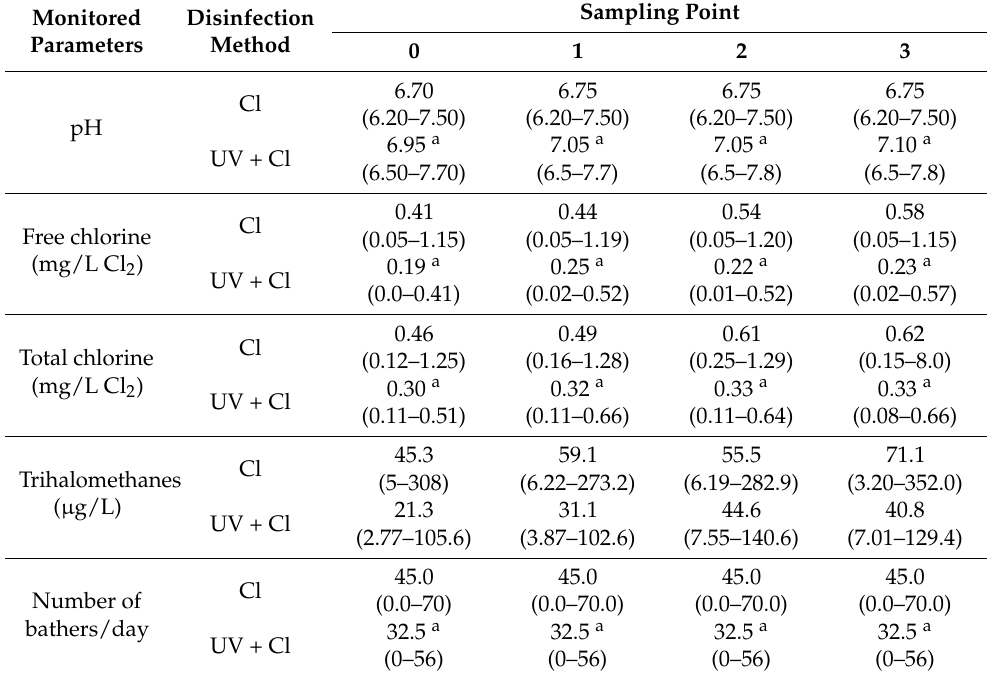
Table 1. Monitored parameters and the number of bathers per day for the analyzed swimming pool water at different applied disinfection methods (Cl and UV + Cl) and sampling points (0–3). The data are presented as the median with minimum and maximum values (N = 90 and N = 126 for Cl and UV + Cl disinfection methods, respectively, at each sampling